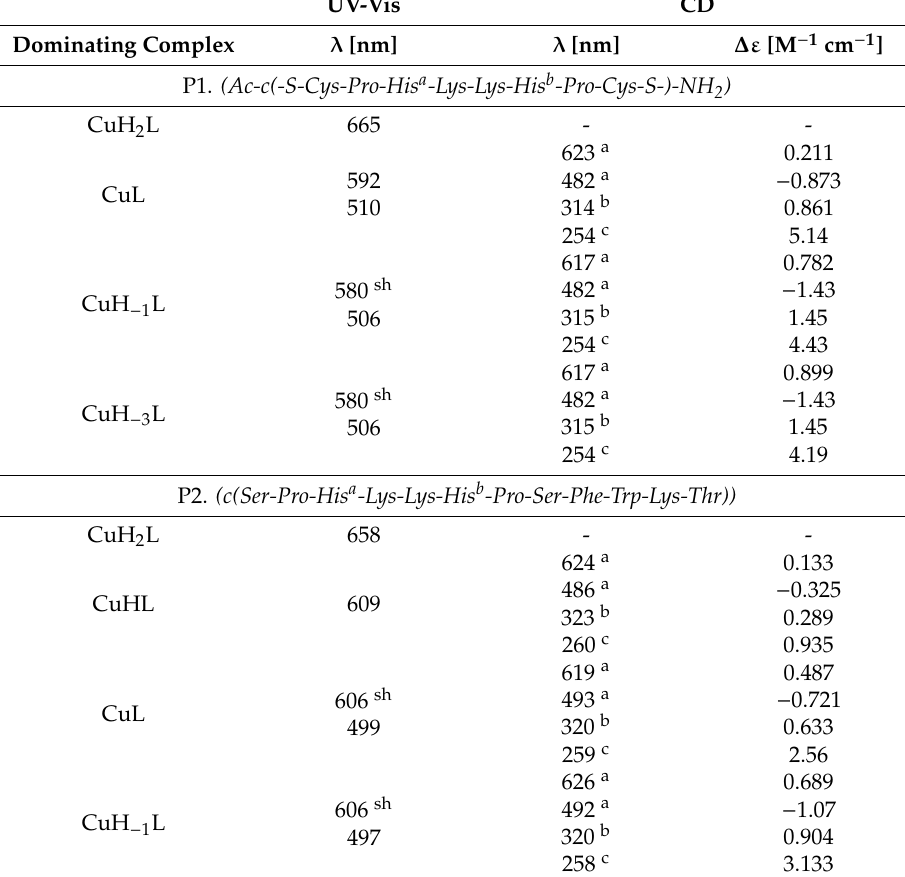
Figure 2. Species distribution curves for the Cu(II) / P1 system in relation to the pH. The ligand concentration was 7 × 10 − 4 mol / L and pH-metric titration was performed in a 0.3 mol / L KCl solution using sample volumes of 1.5 mL. Measurements were carried out in a 2.5–10 pH range, at 25 ◦ C. The ligand to metal ratio was 2:1. Table 2. Spectroscopic data for the Cu(II) / P1 and Cu(II) / P2 systems. The ligand concentrations were 7 × 10 − 4 mol / L and pH-metric titrations were performed in a 0.3 mol / L KCl solution using samples volumes of 2 mL. Measurements were carried out in a 2.5–10 pH range, at 25 ◦ C. The ligand to metal ratios was 2:1 in both analyzed